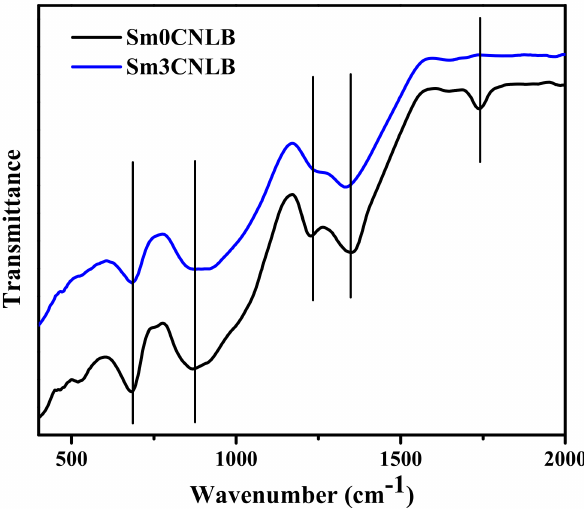
Figure 1. FTIR spectral outcomes of Sm0CNLB and Sm3CNLB glass